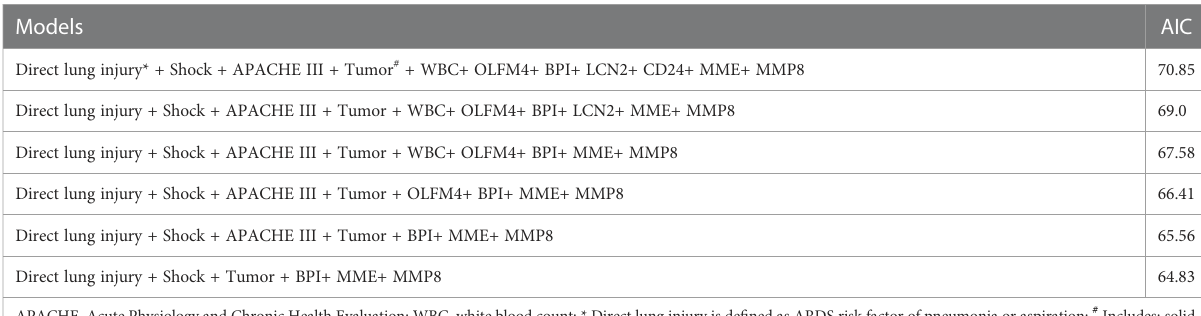
TABLE 3 Comparison of the performance across different models.